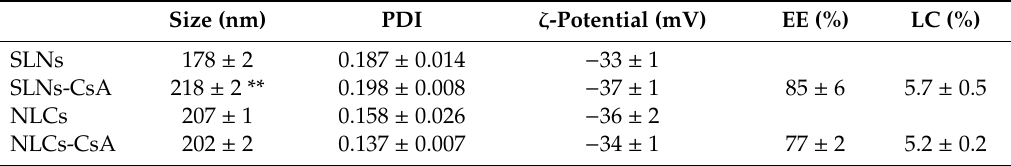
Table 1. Physicochemical characterization of lipid nanoparticles for delivery of CsA.